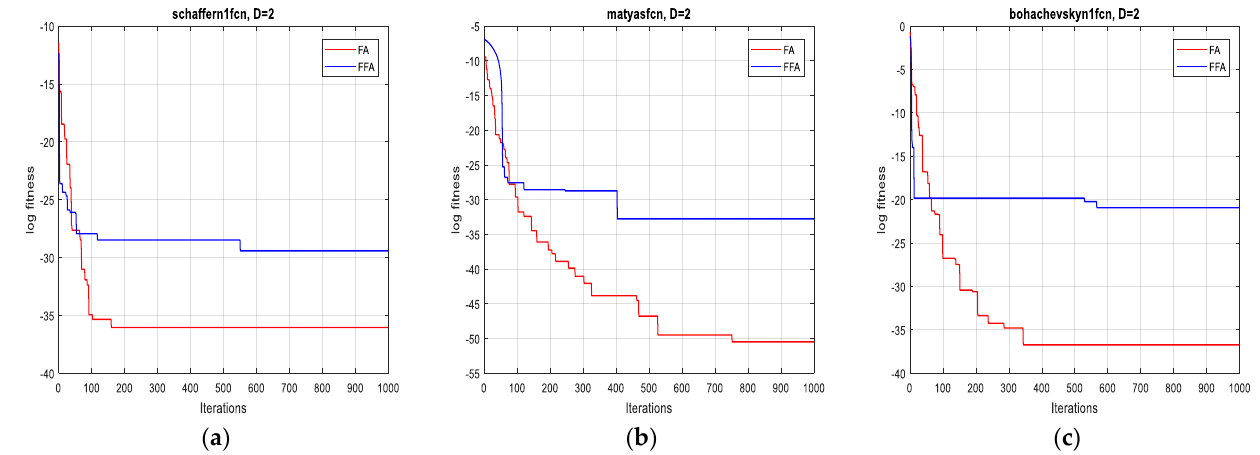
Figure 1. Convergence curves of FFA and FA for the functions: ( a ) F1; ( b ) F2 and ( c ) F3 (2D).